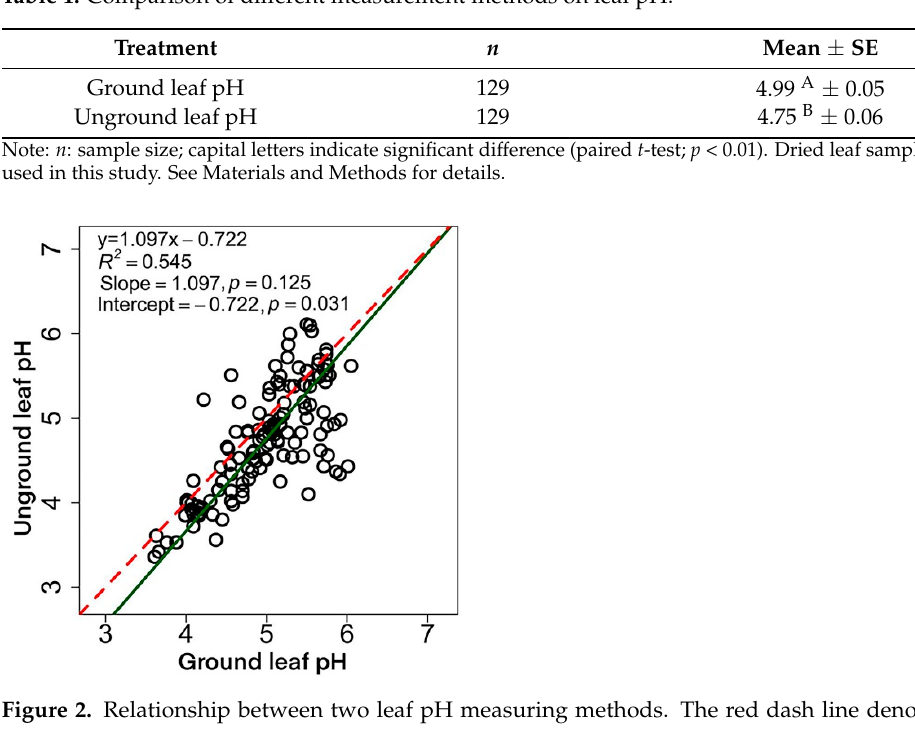
Table 1. Comparison of different measurement methods on leaf pH.